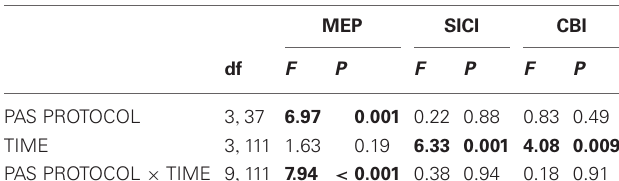
Table 1 | Mixed rmANOVA of the CB → M1 PAS effects on MEP, SICI, and